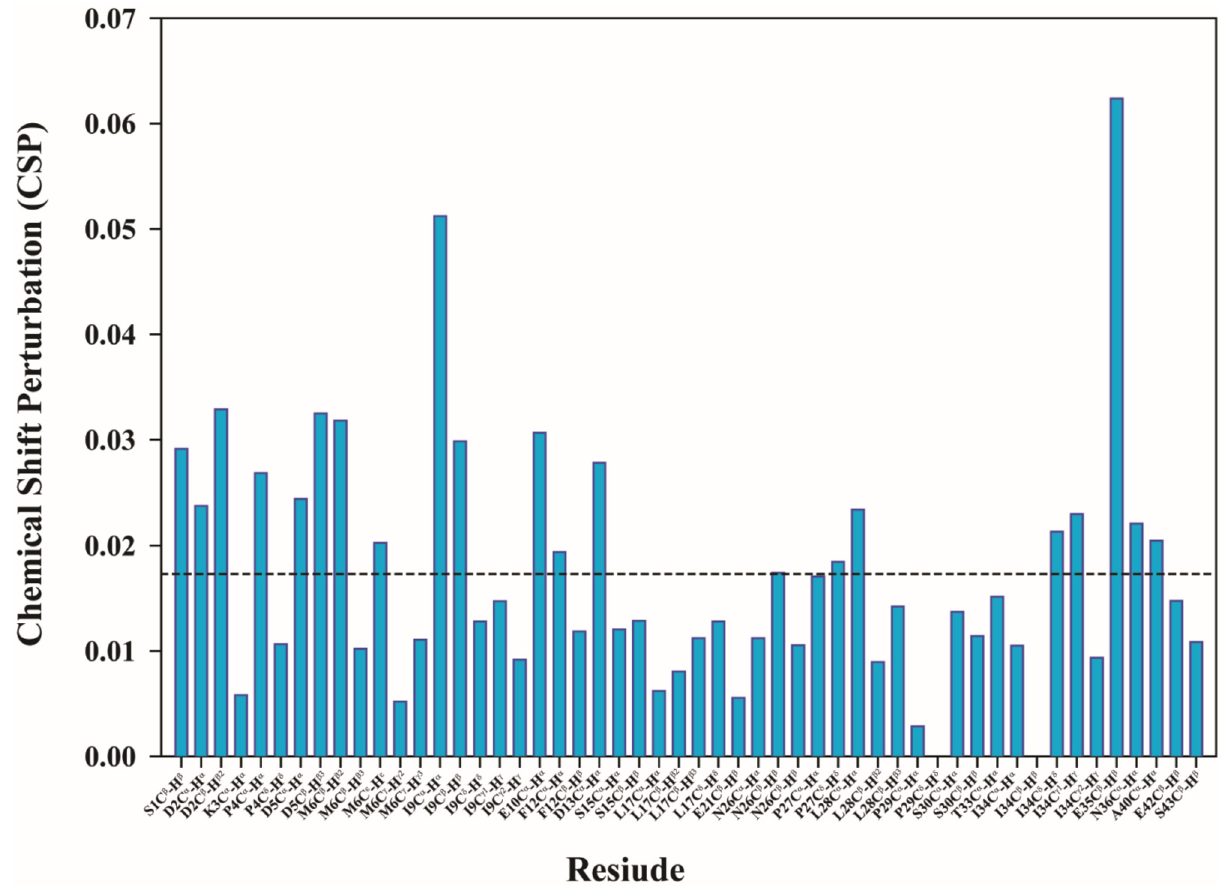
Figure 2. The chemical shift perturbation (CSP) plot for the 48 distinct peaks from the overlay of the two-dimensional 13 C- 1 H HSQC spectra in free form and with thymosin:Al 3+ ratio 1:5.The formula used for CSP is Sqrt [1/2( δ H2 + α ∗ δ 13C2 )] as suggested by Willamson [26]. The α was kept